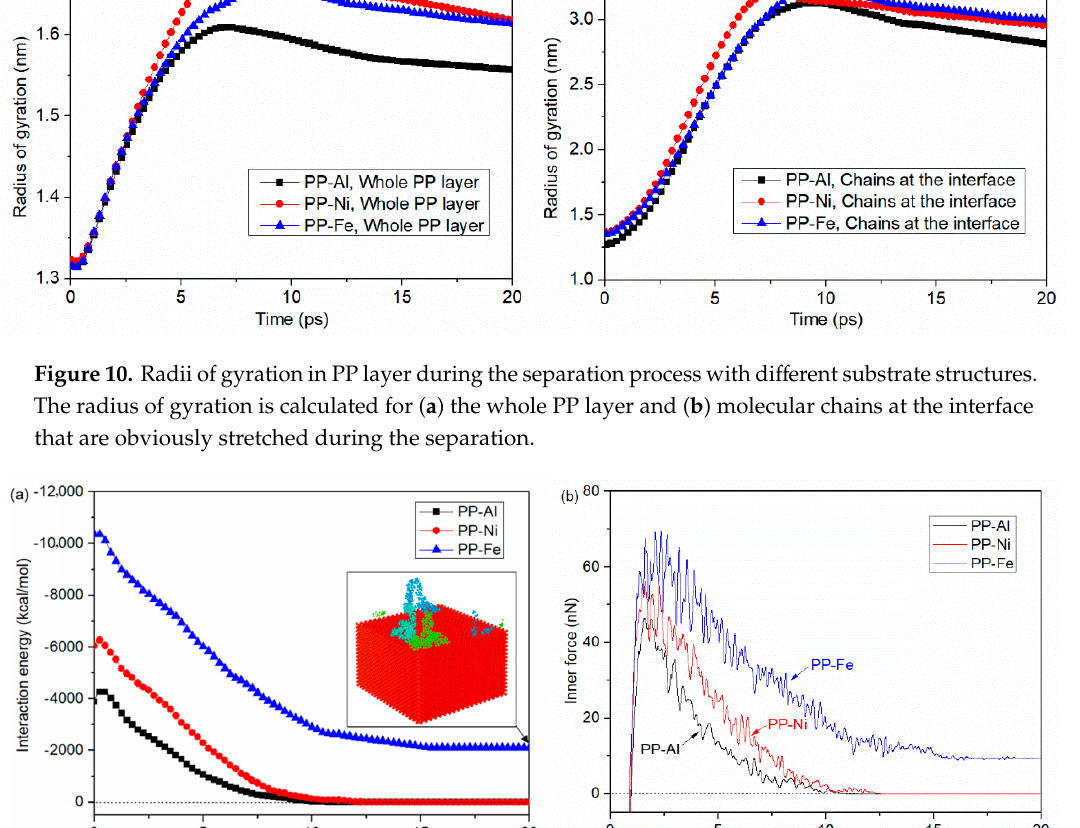
Figure 11. ( a ) interaction energies of injection-molded polymer-metal hybrid structure and ( b ) inner forces in PP layer during the separation process with different substrates. forces in PP layer during the separation process with di ff erent